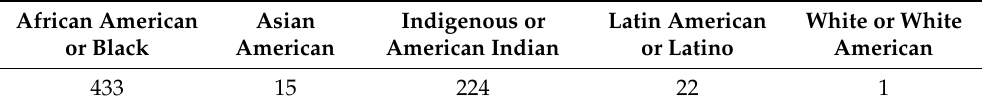
Table 1. Total times each of the following terms is used in a subject heading in the CAC.